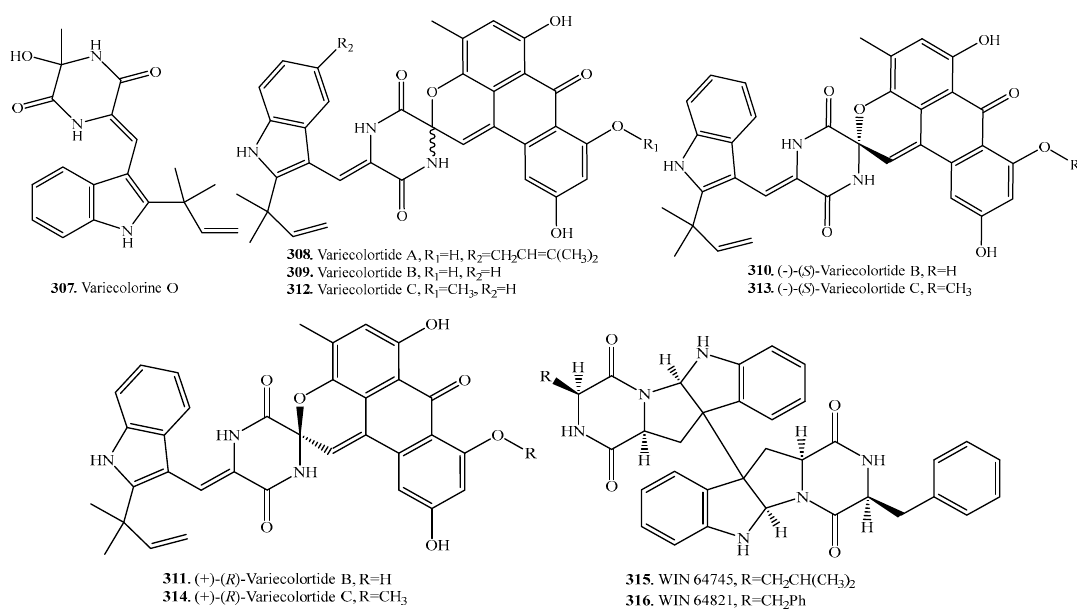
Figure 3. Structures of the tryptophan-Xaa cyclodipeptide analogs isolated from fungi.